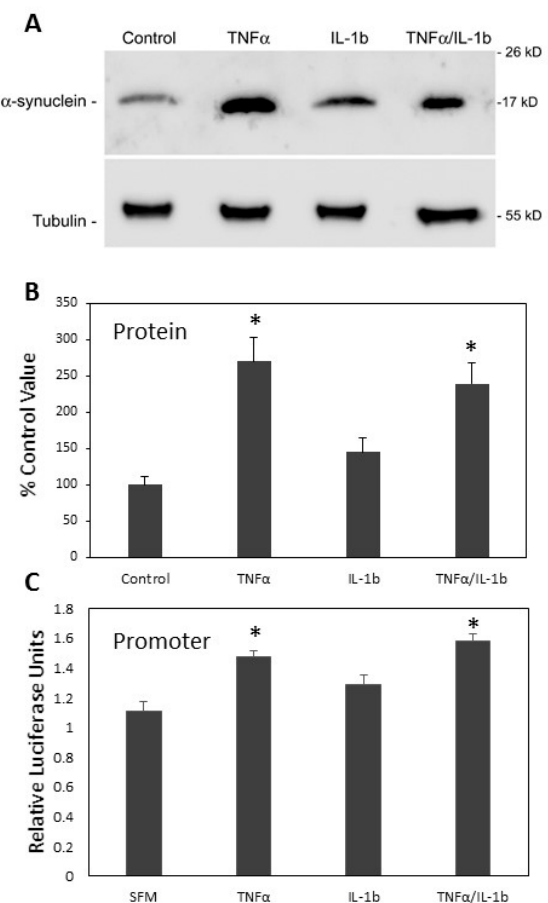
Figure 9. Cytokines and α -synuclein expression. ( A ) We tested cytokines to determine if they could induce increased expression of α -syn in SH-SY5Y cells. SH-SY5Y cells were grown in serum free medium and 50 ng/mL of either mouse TNF α , IL-1 β , or both was applied to the cells twice in a 24 h period. Western blot was then carried out to assess α -syn expression levels. Tubulin was also assessed as a loading control. ( B ) Analysis showed that only TNF α or TNF α /IL-1 β caused an increase in α -syn expression. As IL-1 β had no significant effect this result was only due to the presence of TNF α . ( C ) We also tested the effects of the cytokines on the activity of the SNCA promoter reporter − 6.1/ − 1.3 which showed the strongest response to iron-fed conditioned medium. The SH-SY5Y cells transiently transfected with the reporter were treated similarly with the cytokines. Luciferase activity was significantly ( p < 0.05) increased only for cells treated with TNF α alone or in combination with IL-1 β . Shown are the mean and S.E.M. of four separate